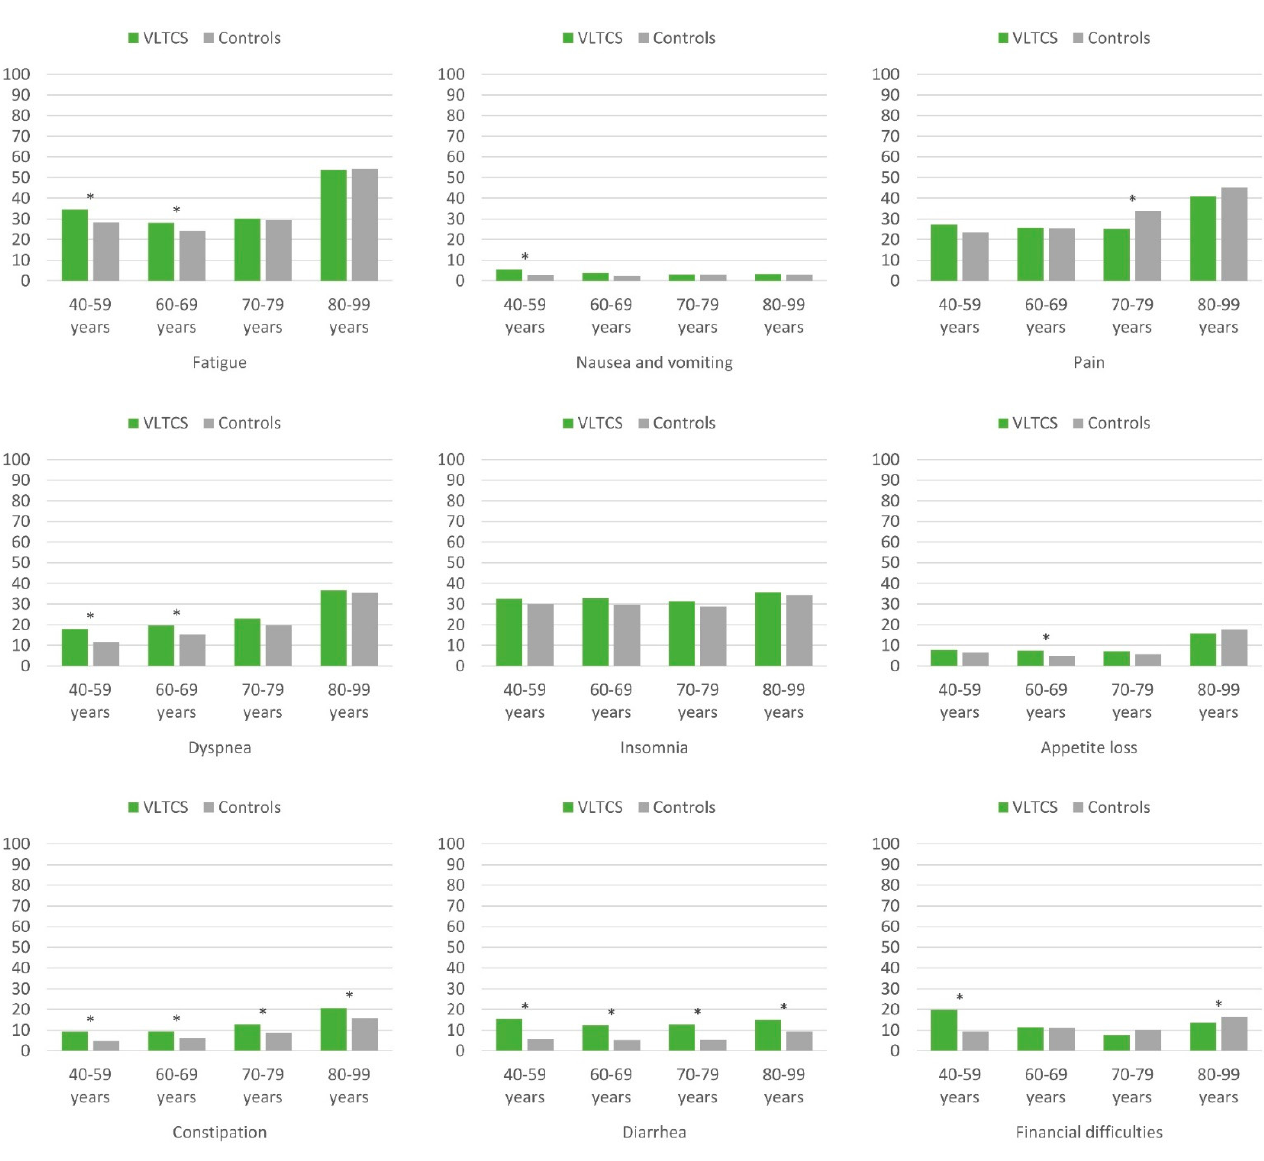
Figure 3. EORTC QLQ-C30 symptom items and scores of very long-term cancer survivors and population controls, stratified by age and adjusted for age, sex, and education. VLTCS, very long-term cancer survivors (recruited via population-based cancer registries). Asterisks (*) mark statistically significant subgroup differences ( p < 0.05). All results are based on 25 imputations of missing values.